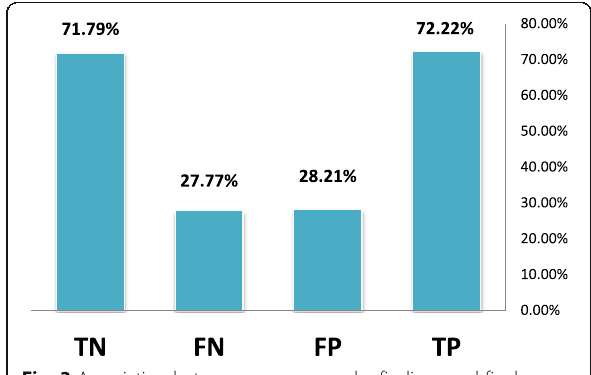
Fig. 3 Association between mammography findings and